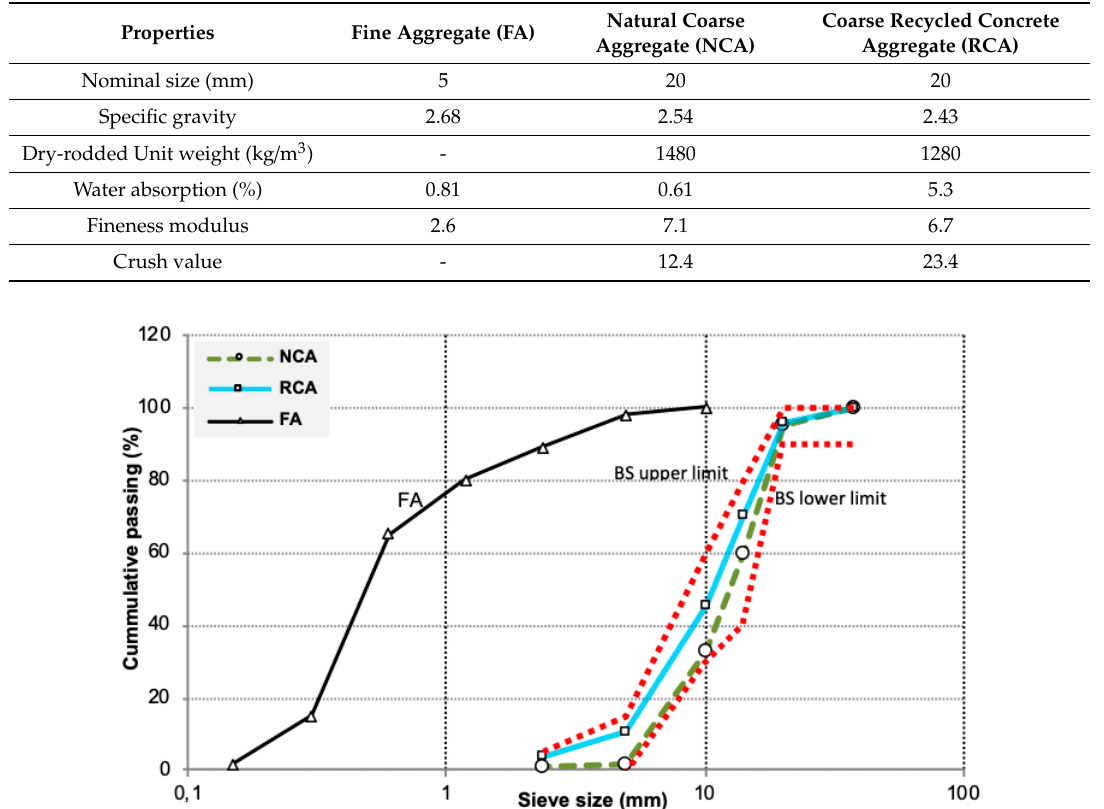
Table 1. Properties of coarse and fine aggregates used.